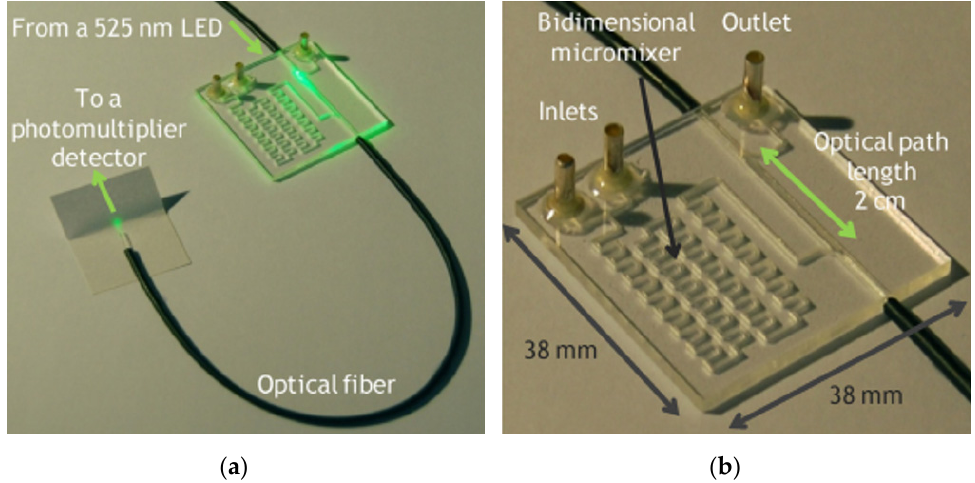
Figure 4. Images of a microfluidic chip for the continuous monitoring of Hg (II) [135]. ( a ) Microfluidic chip with optical fiber for coupling with photomultiplier detector. ( b ) Detailed view of the chip with integrated micromixer and 2cm optical channel. Figure reproduced with permission from Elsevier.